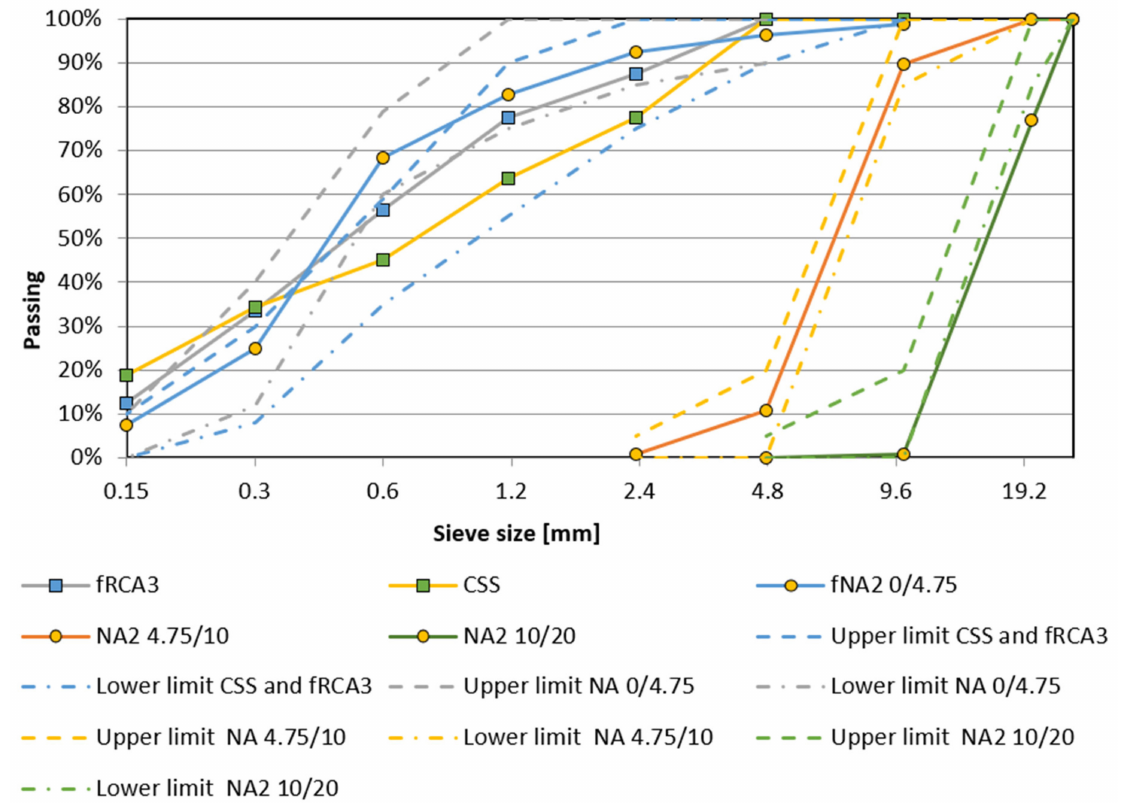
Figure 3. Particle size distribution of aggregates used by the Indian